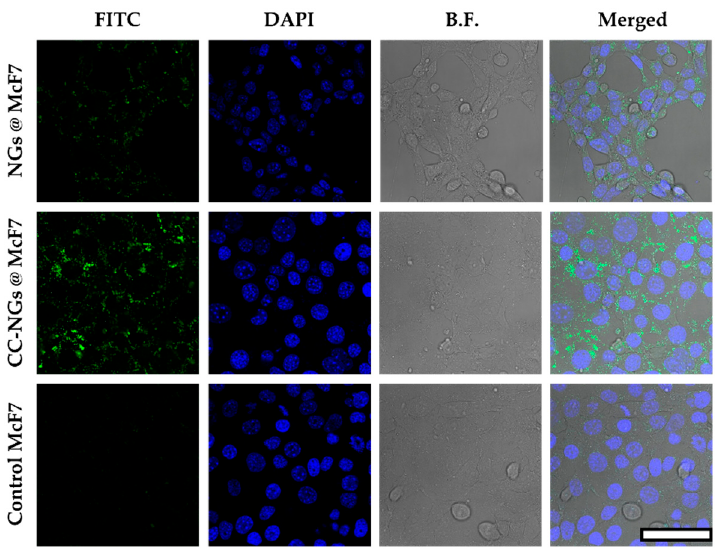
Figure 6. Confocal laser scanning microscopy (CLSM) of McF7 cells. Nuclei were stained with Hoechst dye (blue). Cells were incubated for 16 h at 37 °C with 0.5 mg·mL − 1 of loaded and unloaded FITC-labeled NGs (green). Untreated cells were measured as a control (scale bar indicates 75 μ m).